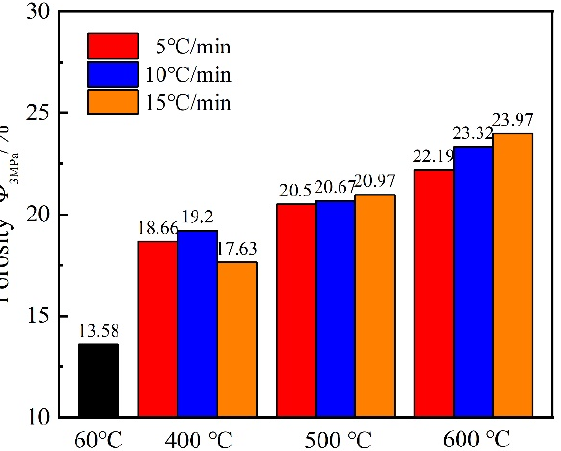
Figure 4. Variations in initial porosity of mortar with temperature and heating rate (Inset: porosity with respect to reference temperature 60 ◦